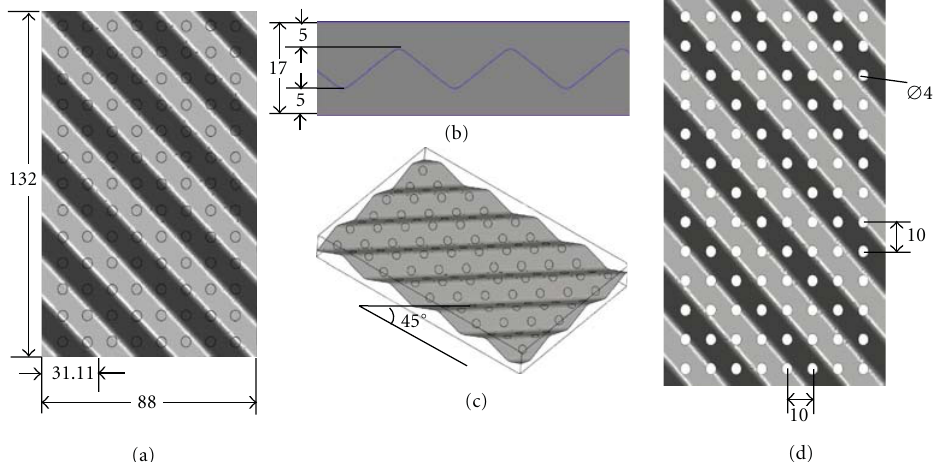
Figure 3: Schematic view of geometry of corrugated sheet of packing. (a) Top view: geometry without holes. (b) Side view. (c) Isometric view (d) Top view: geometry with holes. All dimensions are in mm.